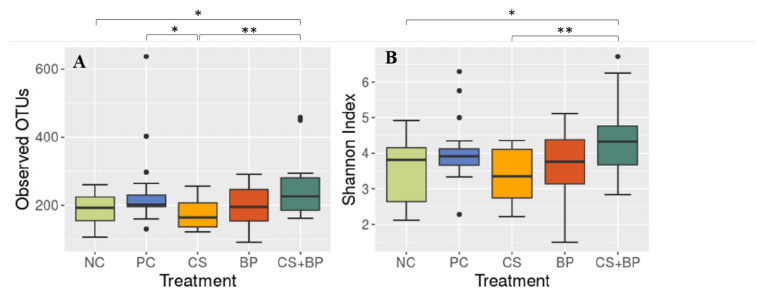
Figure 4. Alpha diversity of the jejunal microbiotas in five treatment groups of broilers. ( A ) Observed OTUs and ( B ) Shannon index. Significant differences at different p- values are indicated by * (<0.05) and ** (<0.01).